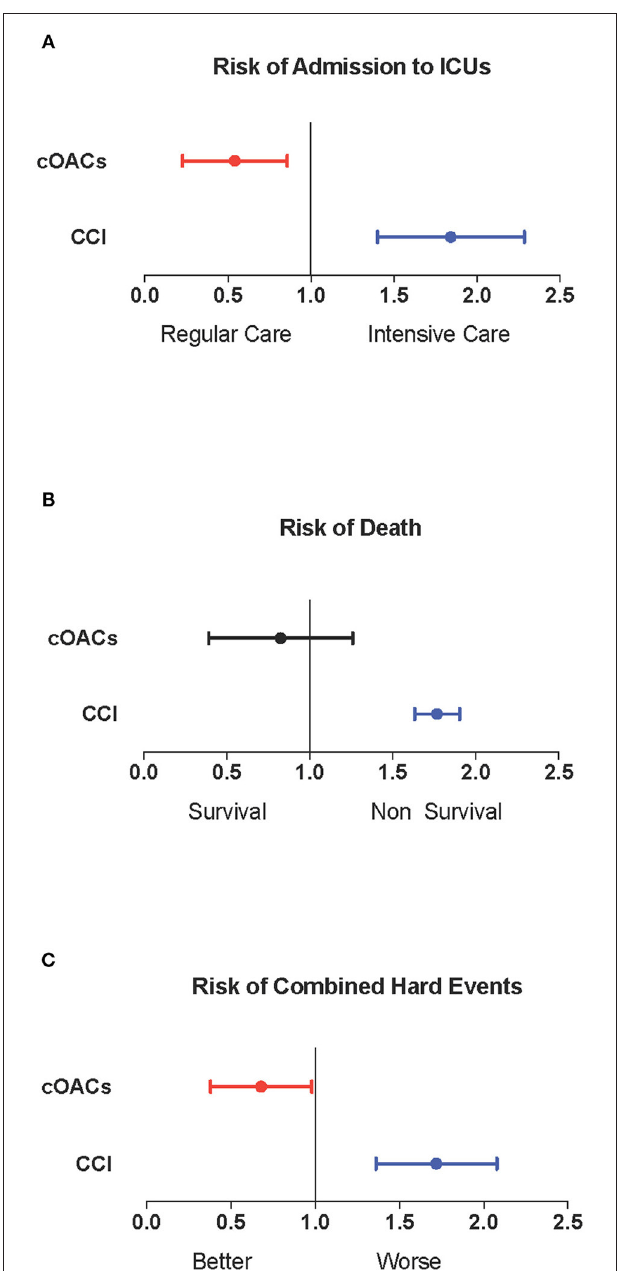
FIGURE 3 | (A) Odds ratio and confidence intervals for admission to intensive care units; cOACs: T = − 0.825, p < 0.01; CCI: T = 0.085, p < 0.003; male sex: T = 0.602; p < 0.001. (B) Odds ratio and confidence intervals for deaths; CCI: T = 0.567, p < 0.001. (C) Odds ratio and confidence intervals for combined hard events (deaths and ICU admissions); cOACs: T = − 0.455; p < 0.05; male sex: T = 0.527; p < 0.001; CCI: T = 0.257; p < 0.001. CCI, Charlson comorbidity index; cOACs, chronic oral anticoagulants; ICU, intensive care units.